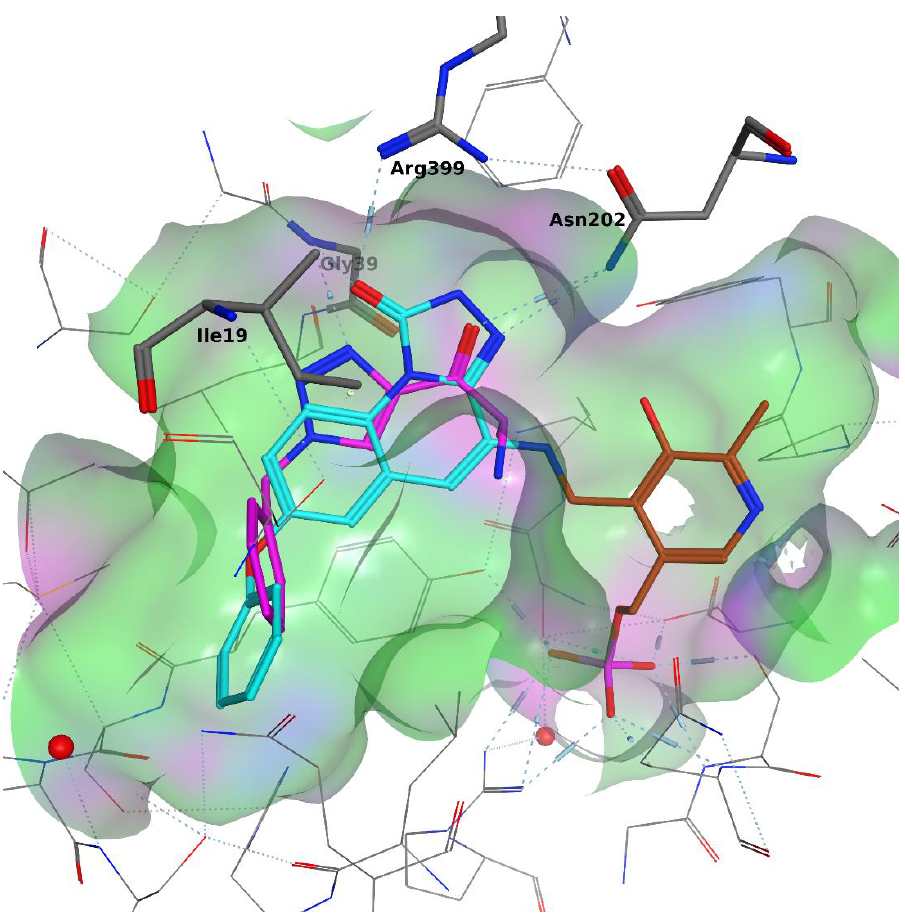
Figure 5. Structure of the representative triazole-based amino ketone (purple) in an overlay with the 4GDY ligand (cyan), which is covalently bound to the cofactor (brown) inside the KAT-II binding pocket. The triazole nitrogen binds to G39, but not to R399. The ketone oxygen binds to N202. An H –π interaction between the triazole π system and an Ile19 hydrogen is also visible. Coloring of the surface is purple: H-bonding, green: hydrophobic, and blue: mild polar. PF-04859989 ( 3 ) is shown in red to show the overlay of the equivalent functional groups.